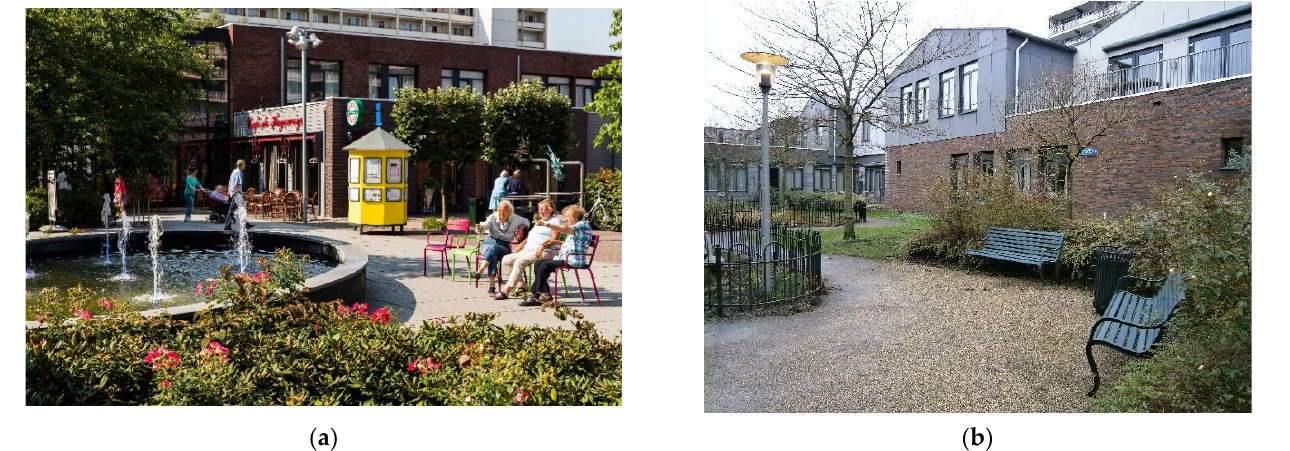
Figure 21. Outdoor spaces in De Hogeweyk. Source: ( a ) De Hogeweyk, ( b ) Own elaboration, 2020. ( a ) The public space at the entrance of De Hogeweyk is a public square with different stay areas with amenities such as a pond and fountain, a big chess board, terraces, and different spots to stop by and rest or gather. Natural stimuli such as birds or ducks are part of the biodiversity in the outdoor space. ( b ) A total of 23 houses are organized in two-story buildings around outdoor gardens with different identities and designs. There are benches, lamps, and fences as if it was any other quiet public space in the city.